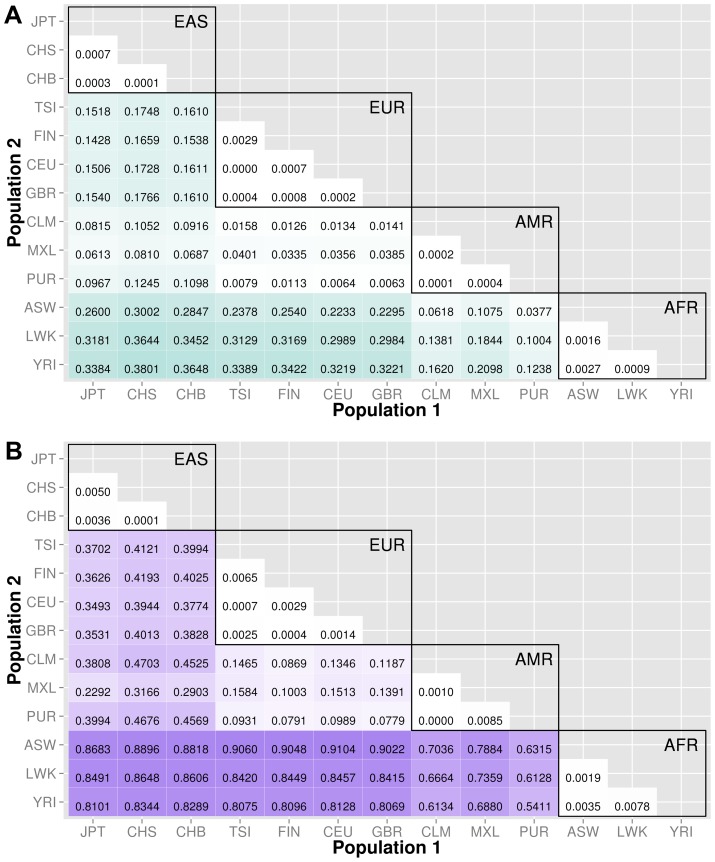
Proportion of significantly different bins in A) ORegAnno regulatory and B) pathway feature analysis.The abbreviations for the each population on are on the x and y-axes. The numbers in each block and the color intensity [0,1] indicate the proportion of significant bins (after Bonferroni correction) for the 1000 Genomes populations on each axis, where the darker the color, the higher the proportion of significant bins. In general, the x-axis is organized with African descent populations on the far right and increasing differentiation with regard to low frequency burden towards the left (i.e. populations of Asian descent have the highest proportion of significant bins compared to African descent groups). From more conserved regulatory regions to relatively large binned pathways, Figure 5A shows conservation in comparison to genic regions (Figure 3) and Figure 5B shows occasionally very high proportions of significant bins in parent pathway bins in comparison to genic regions (Figure 3).